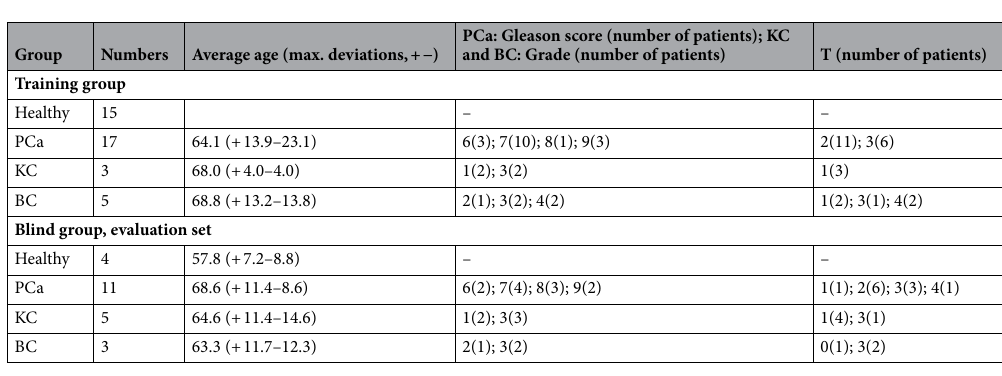
Table 3. Information about